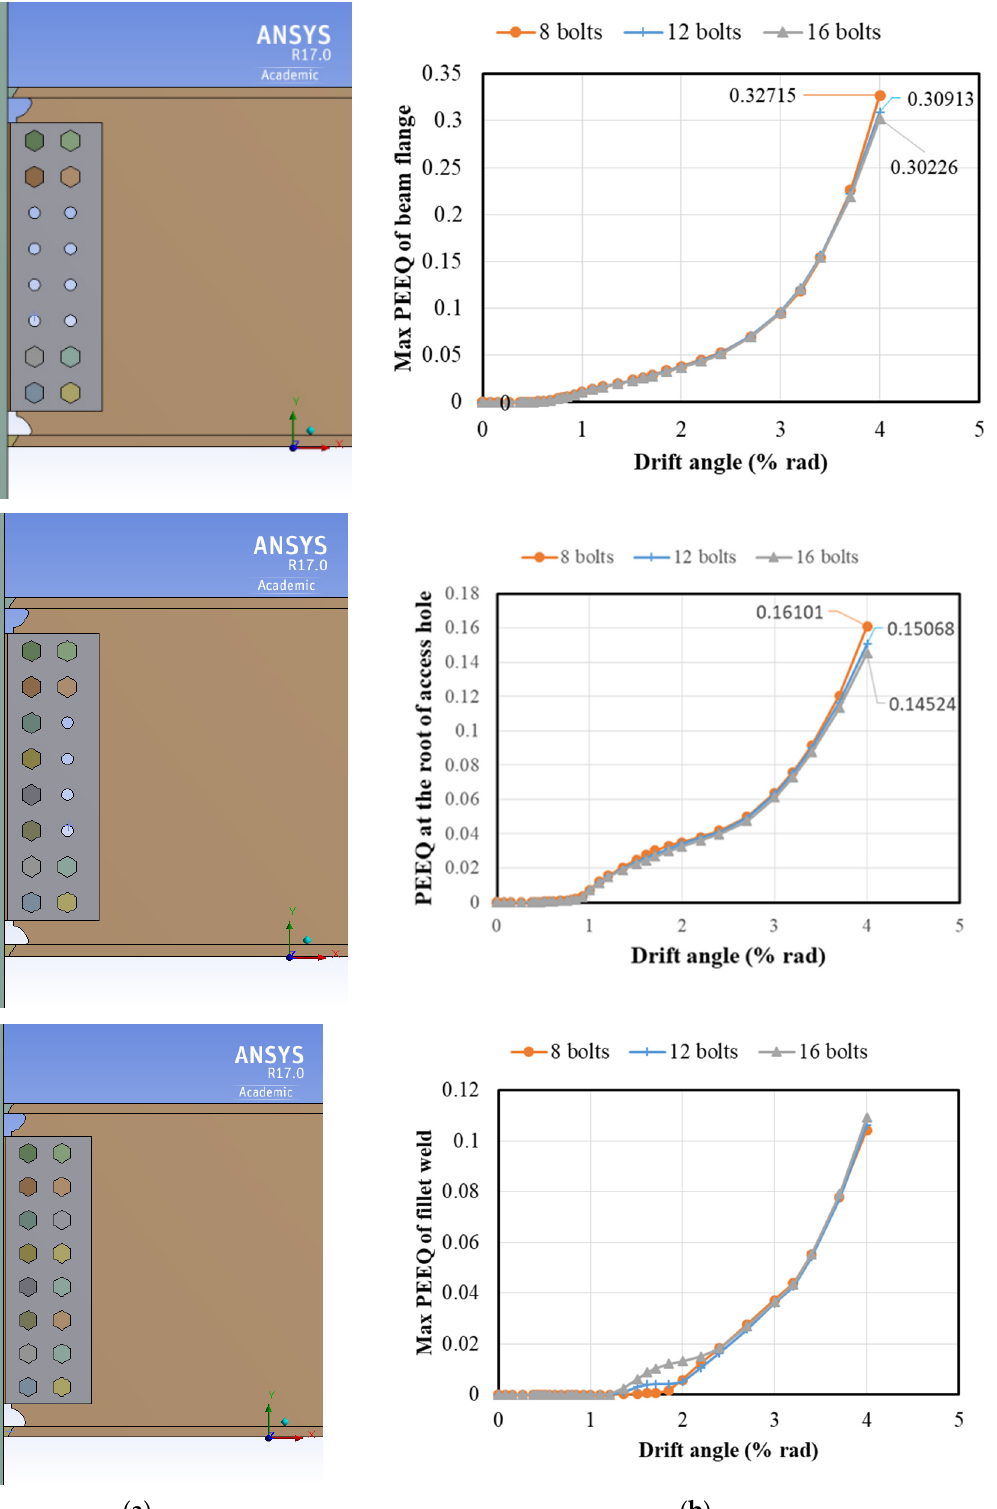
Figure 9. Effects of bolt arrangement and strength: ( a ) FEM model, and ( b ) PEEQ index (for a steel connection with a 22-mm thick shear tab and M22 S10T high-strength bolts).